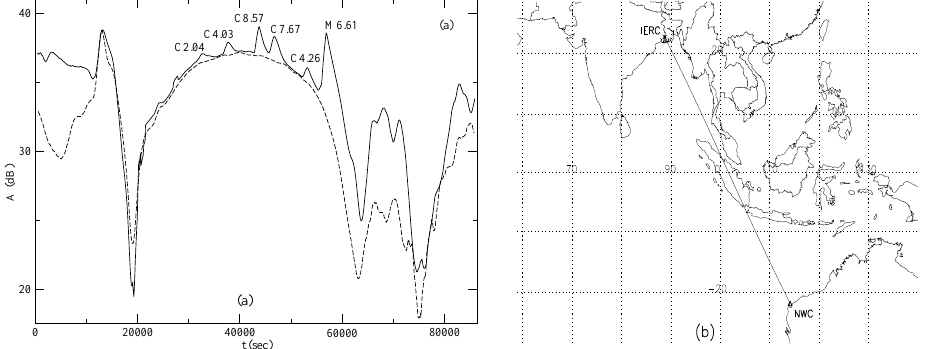
Fig. 1. (a) The amplitude of VLF signal transmitted from the NWC (19.8kHz) station, as a function of time (in IST=UT+5.5h) as recorded at IERC(ICSP), Sitapur, India, on the 18 February 2011. Six solar flares of different classes (C2.04 at 09:04UT, C4.03 at 10:21h, C8.57 at 12:03h, C7.67 at 12:54h, C4.26 at 14:41h and M6.61 at 15:42h) could be seen. A solar-quiet day data is also presented (dotted line) for comparison which was recorded on 12 February 2011. (b) The propagation path from NWC/Australia to IERC(ICSP)/Sitapur, India.